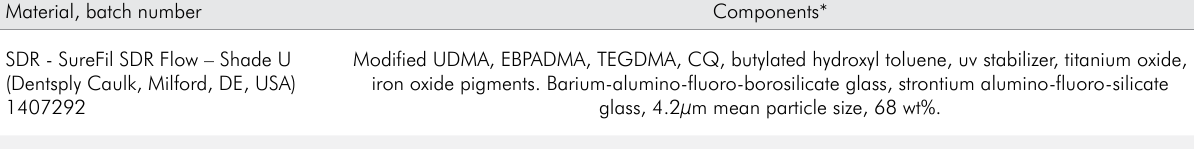
Table 1. Materials manufactures, batch number, and components used in this study. Material, batch